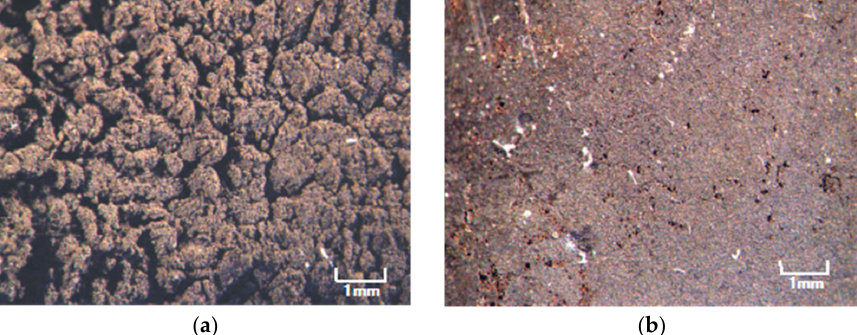
Figure 3. Photographs of the surface at the cathode indicated as ( a ) and anode ( b ) sides of the MCF rubber made by the present new method magnified by a microscope.